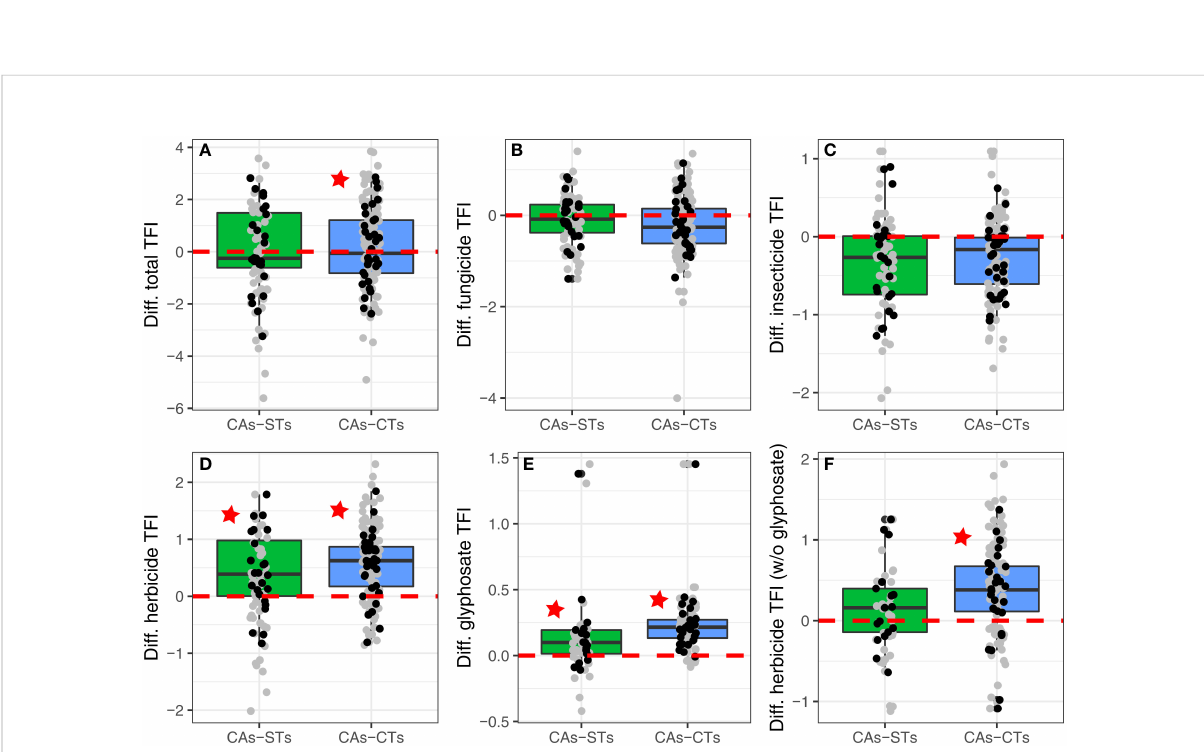
FIGURE 3 Pesticide use in conservation agriculture (CAs). Distributions of the differences in response variables between conservation agriculture systems (CAs) and their reference conventional tillage (CTs, blue boxplots) and super fi cial tillage (STs, green boxplots) based systems for: total treatment frequency index (total TFI including seed treatments, A ), fungicide TFI (B) , insecticides TFI (C) , herbicide TFI (D) , glyphosate-based herbicide TFI (E) , and herbicide TFI without glyphosate (F) . The TFI are those computed with “ at the pest target ” method. Grey dots represent individual differences between systems. Black dots represent average differences per cluster. Red stars indicate signi fi cant differences between CAs and its reference system (either CTs or STs) at p<0.05. Cluster was included as a random effect in the statistical models to account for production situation effects (see details in Table 1).